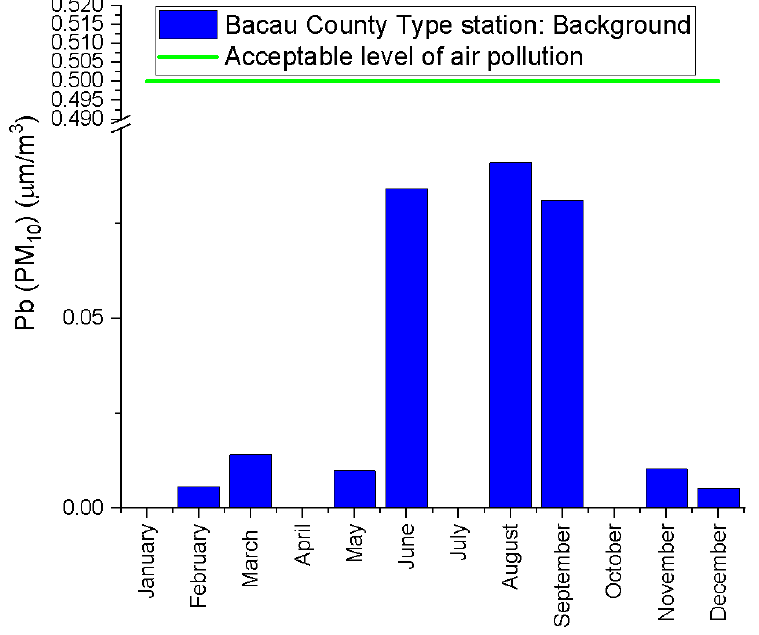
Figure 19. Average Pb concentration in the year 2020. Cadmium is another heavy metal measured in suspended particles in the air with a maximum permissible value of 5 ng m − 3 (Figure 20). The measurements for this parameter did not indicate, as in the case of other heavy metals, overruns. The highest average value recorded in the urban background station of Bacau municipality was 0.36 ng m − 3 in March and the lowest was 0.1 ng m − 3 in September.